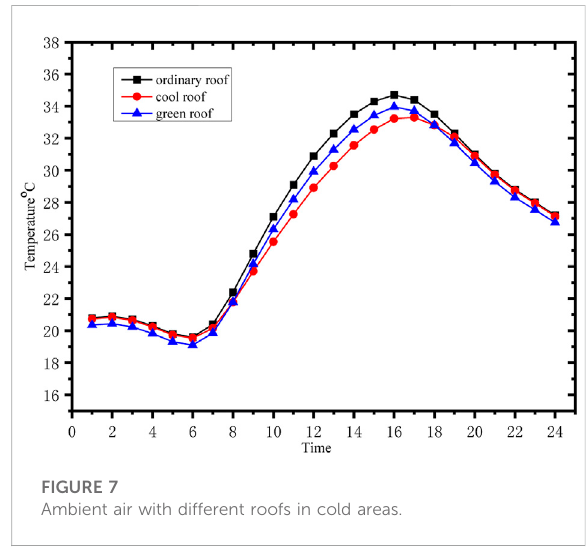
FIGURE 7 Ambient air with different roofs in cold areas.